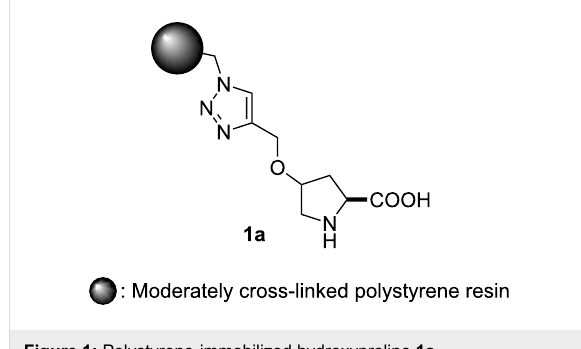
Figure 1: Polystyrene-immobilized hydroxyproline 1a